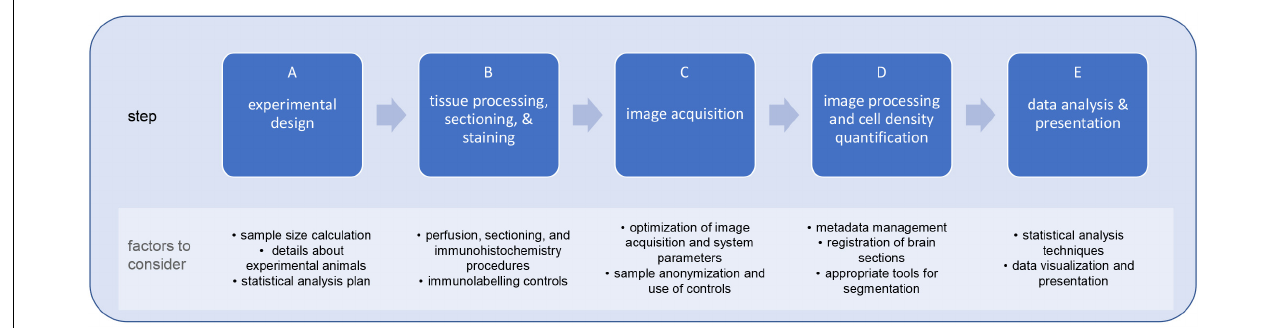
Mead et al., 2012; Festing, 2018) and becomes particularly useful when an effect size cannot be determined through pilot studies or approximated from previous